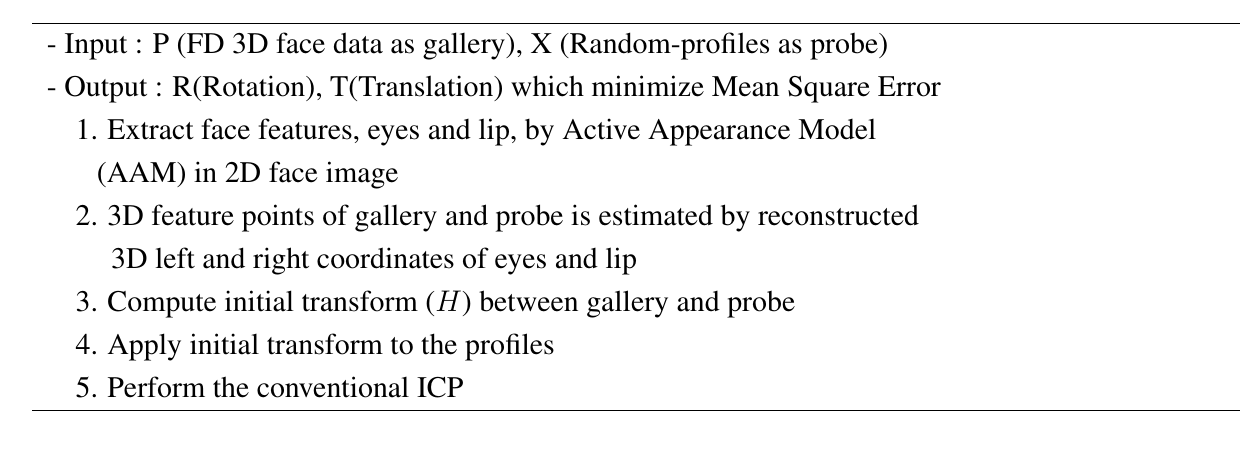
Table 2. Proposed ICP algorithm.